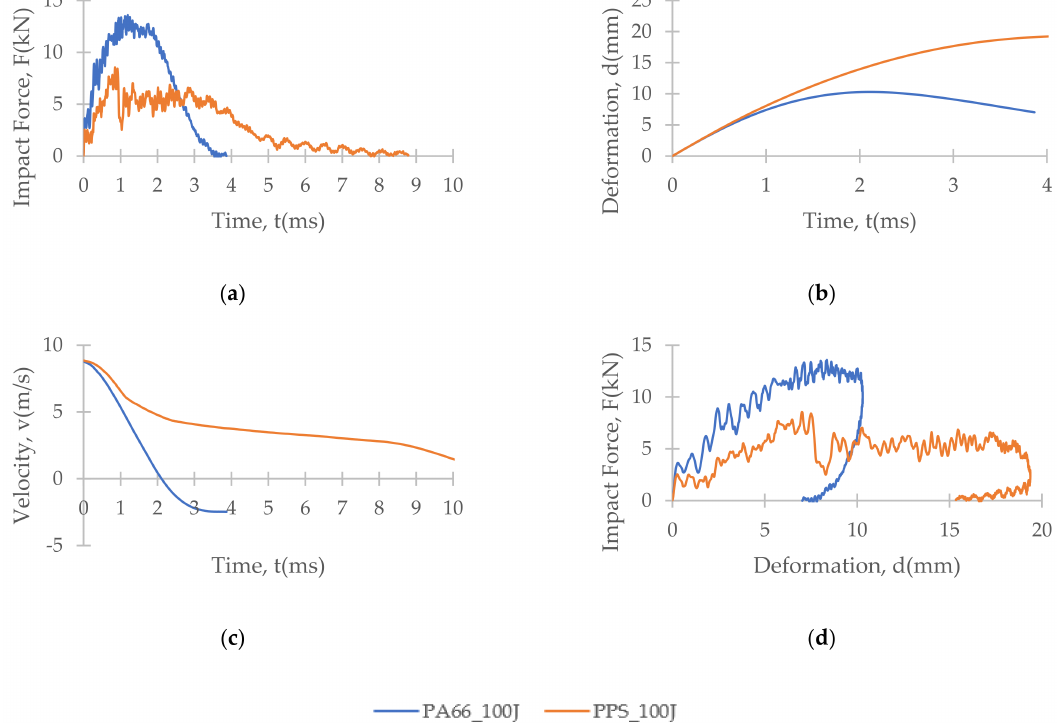
Figure 8. Time histories: ( a ) force-time, ( b ) deformation-time and ( c ) velocity-time; and ( d ) force-displacement plot of T700/PA6.6 and T700/PPS CFRTP composite systems under 100 J impact